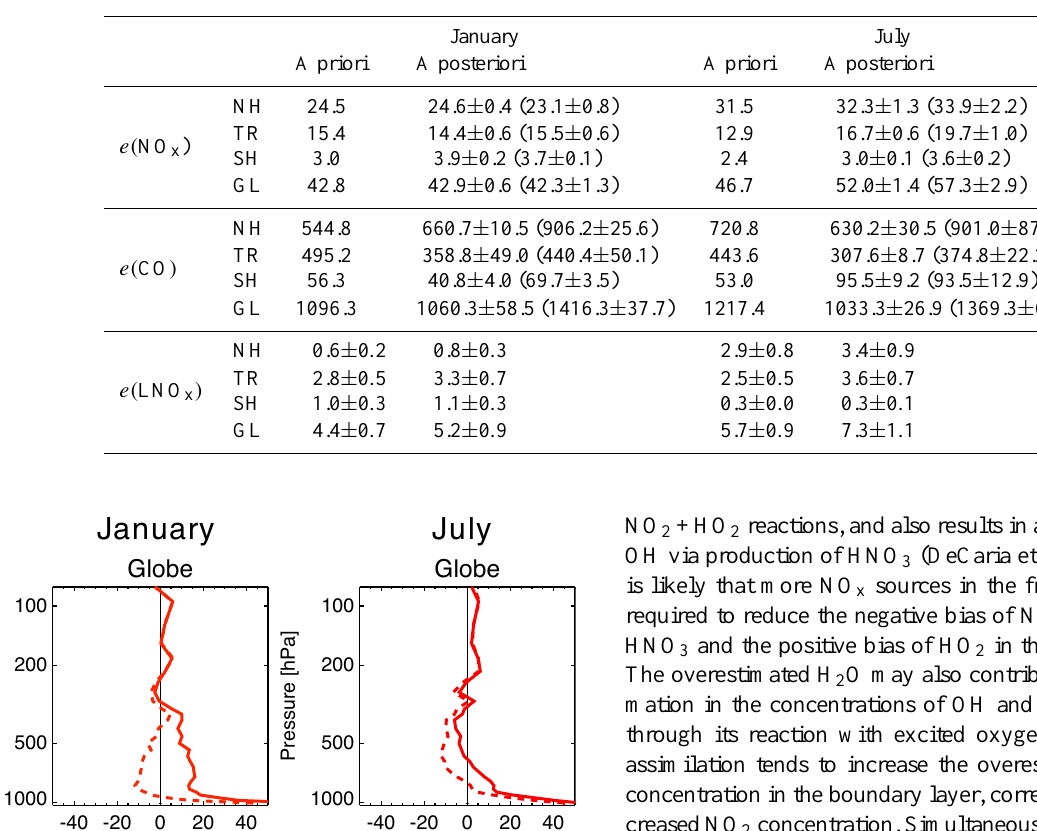
Table 6. The 15-day means (from the 16–30 of each month) and the standard deviations (from the means) of the global and regional surface NO x emissions ( e (NO x ), in TgNyr − 1 ), lightning NO x emissions ( e( LNO x ), in TgNyr − 1 ), and surface CO emissions ( e( CO), in TgCOyr − 1 ) obtained from the a priori emissions and the a posteriori emissions. GL is global (90 ◦ S–90 ◦ N); NH is the Northern Hemisphere (20 ◦ N–90 ◦ N); TR is the tropics (20 ◦ S–20 ◦ N); and SH is the Southern Hemisphere (90 ◦ S–20 ◦ S). The emissions optimized from the full assimilation run and the emission inversion run (in bracket) are presented.